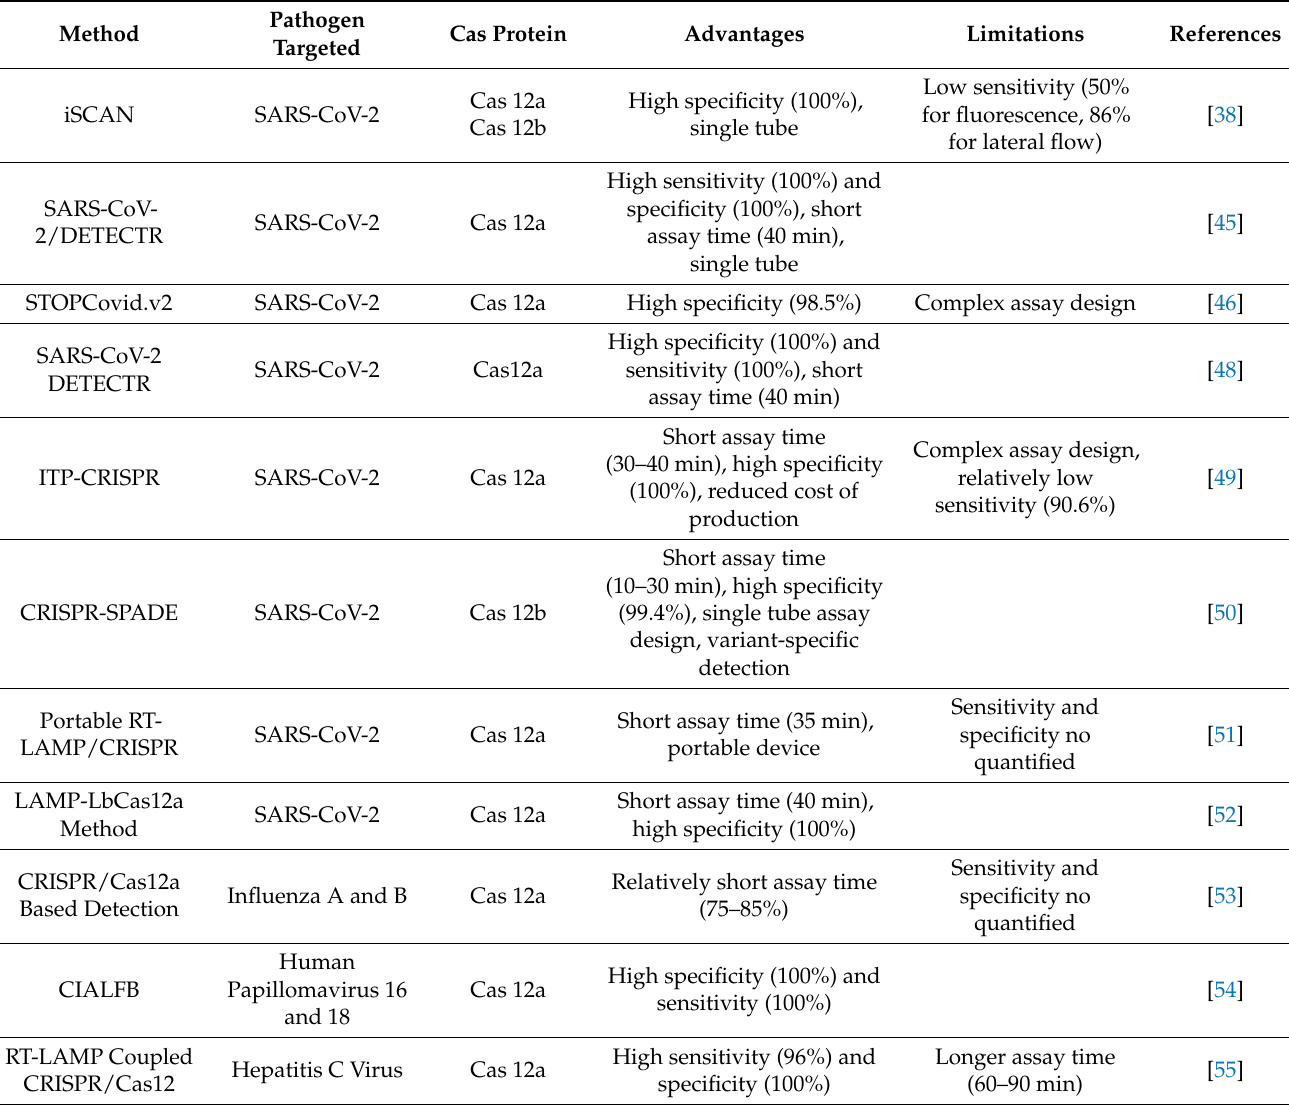
Table 1. Advantages and limitations of pathogen-specific point-of-care